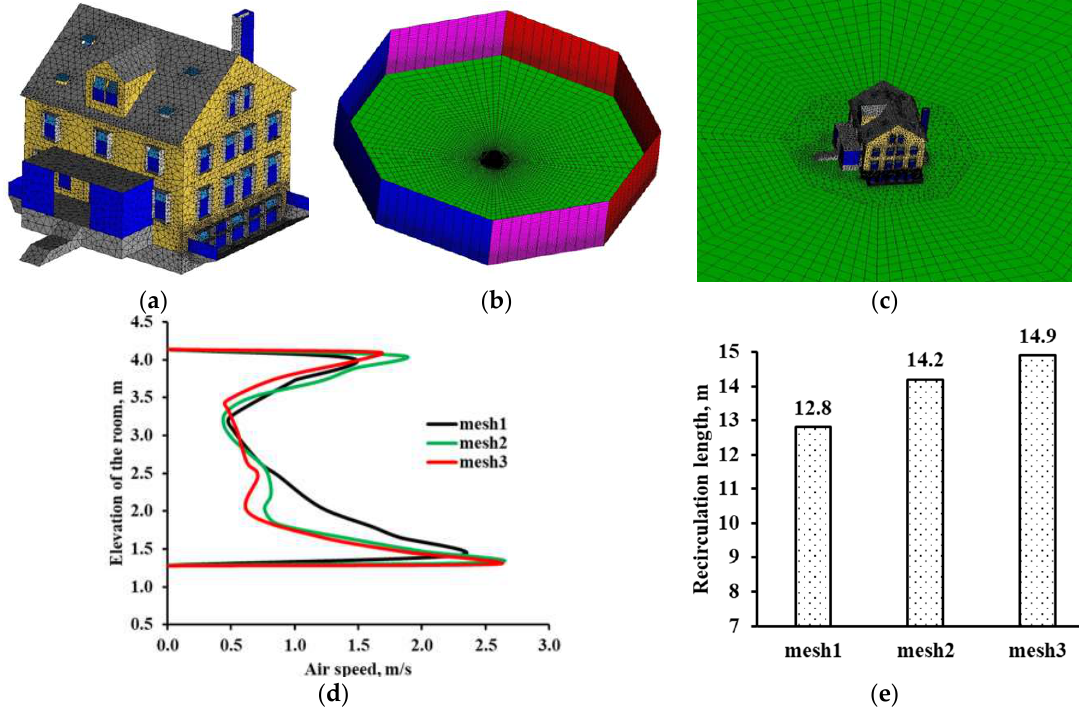
Figure 3. ( a ) Geometry and mesh of the real-time CFD model; ( b ) octagonal domain; ( c ) mixed mesh; ( d ) air speed profiles of three mesh numbers; ( e ) recirculation length of the circulation zone on the downwind side of the building for three mesh numbers.